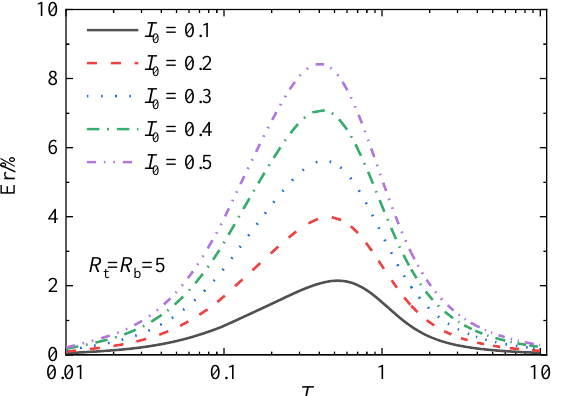
Figure 11. Deviations in the consolidation degree between Darcy’s law and non-Darcian flow under a single-side impeded drainage boundary with lower I 0 .